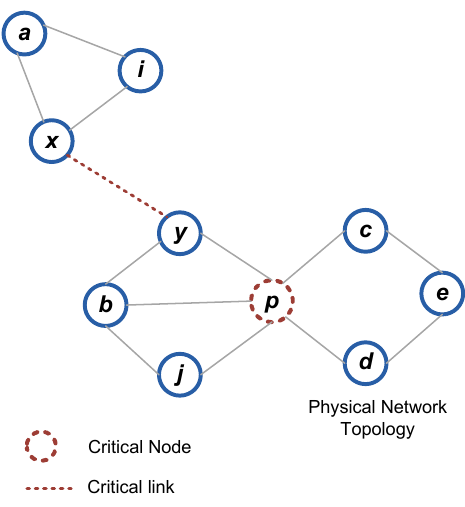
Figure 3. k-hop critical node/link